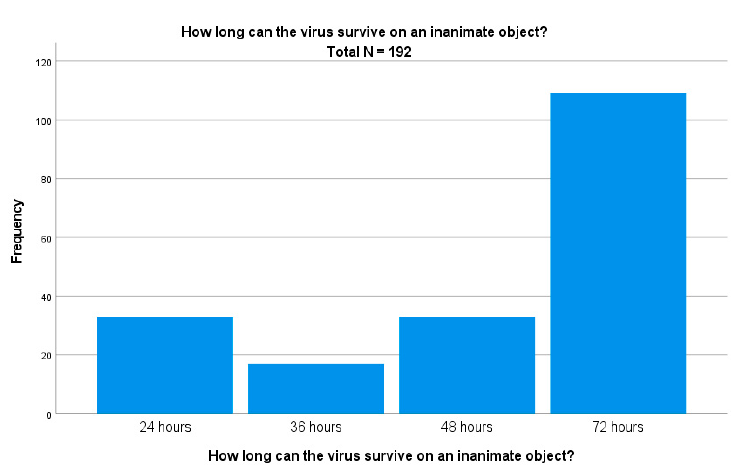
Figure 3. Knowledge based on survival on an inanimate object.